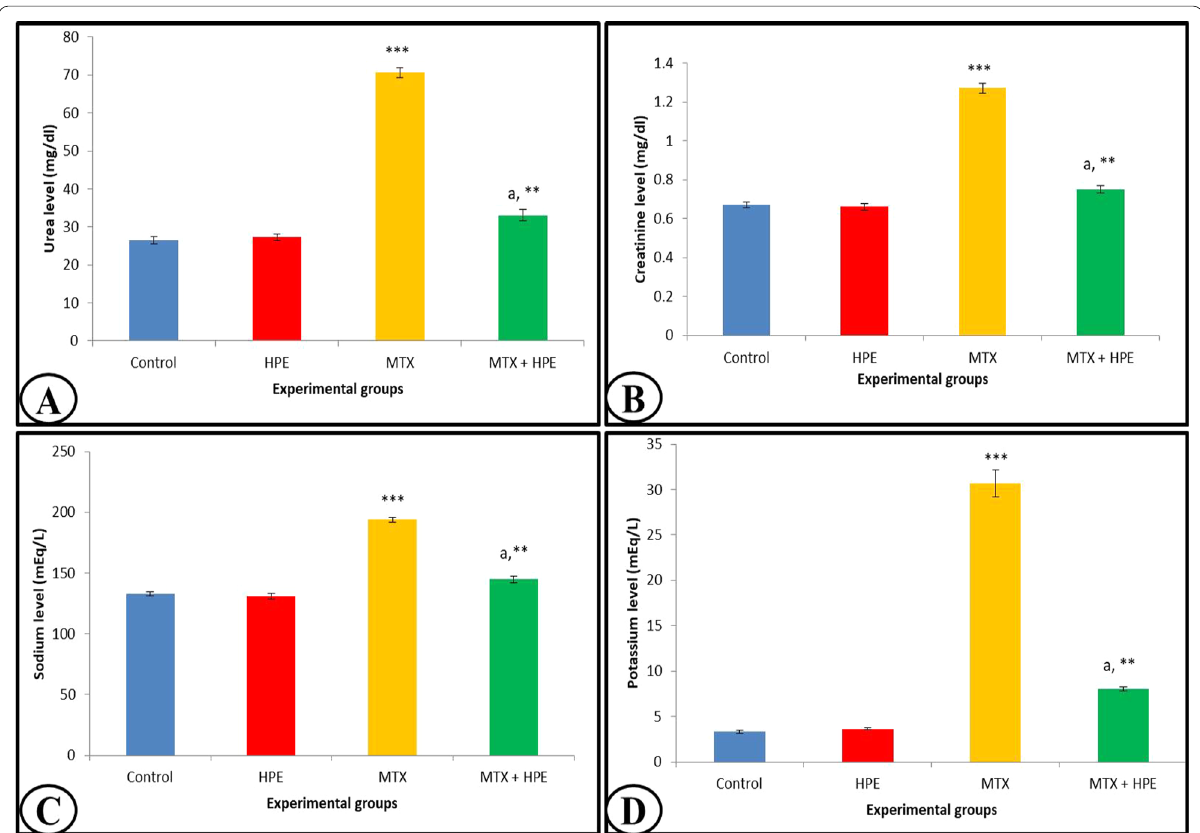
Fig. 1 The levels of ( A ) urea, ( B ) creatinine, ( C ) sodium and ( D ) potassium in sera of animals of the different experimental groups. (***): highly significant at p < 0.001 compared with the control group. (**): significant at p < 0.01 compared with the control group. (a): highly significant at p < 0.001 compared with MTX